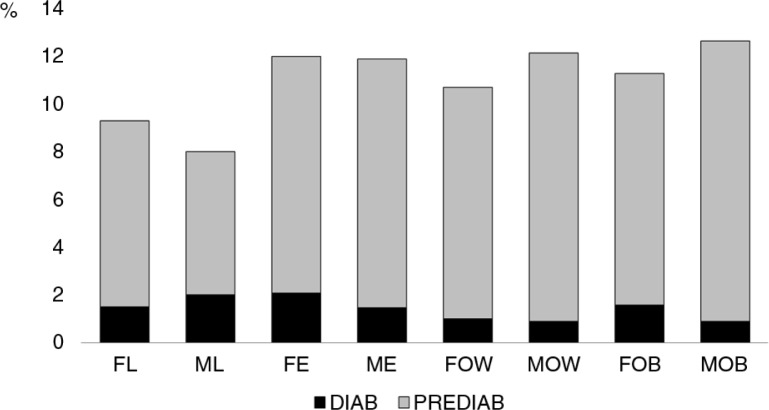
Fasting glucose levels and body mass in%. FL, females in low weight; ML, males in low weight; FE, females in eutrophic weight; ME, men in eutrophic weight; FOW, females in overweight; MOW, males in overweight; FOB, females in obesity; MOB, males in obesity. Gray, 5.6–6.9 mmol/L prediabetes (PREDIAB). Black, ≥7 mmol/L diabetes (DIAB).